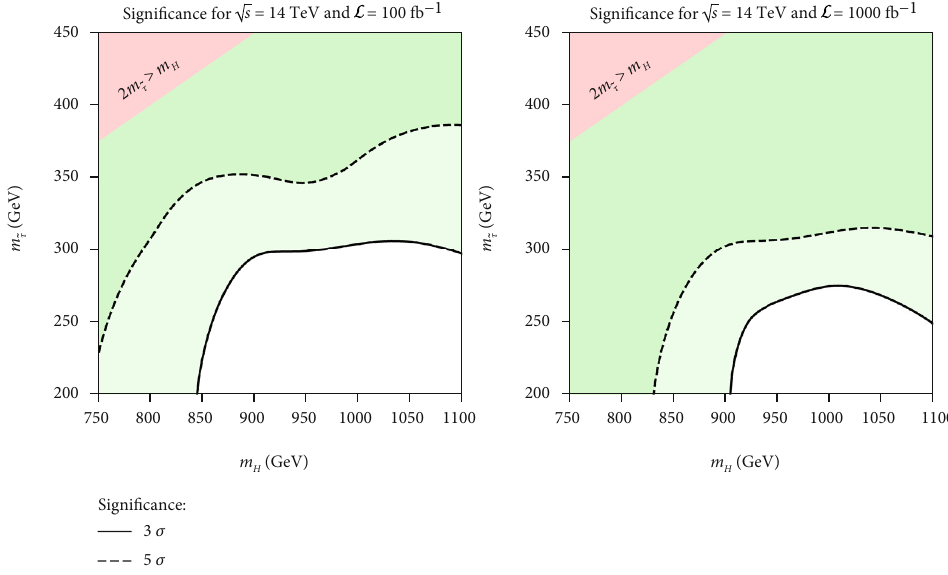
ffiffi p = 14 TeV and total integrated s